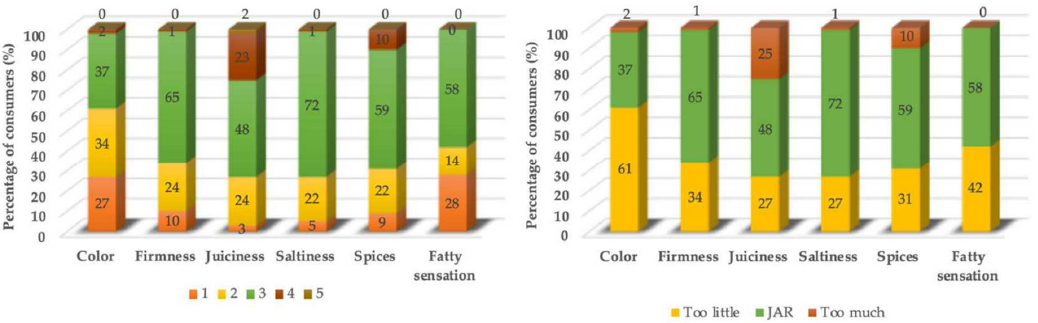
Figure 6. Results of the Just About Right (JAR) scale for reduced fat, preservative-free meatballs (AI) performed by consumers ( n = 84).